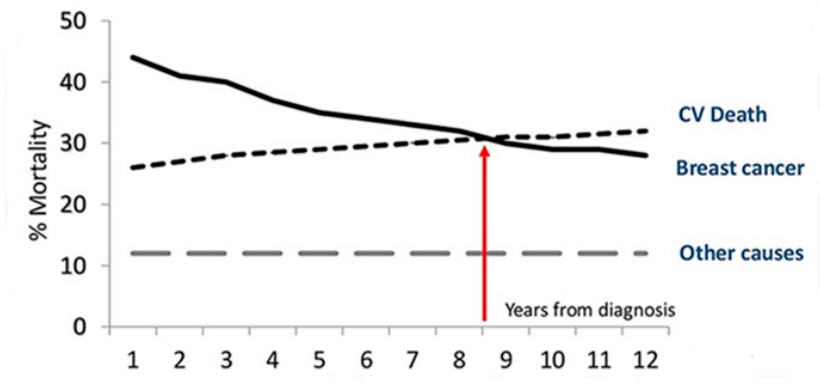
Figure 1. Proportional distribution of the main causes of death by time since the diagnosis of breast cancer.